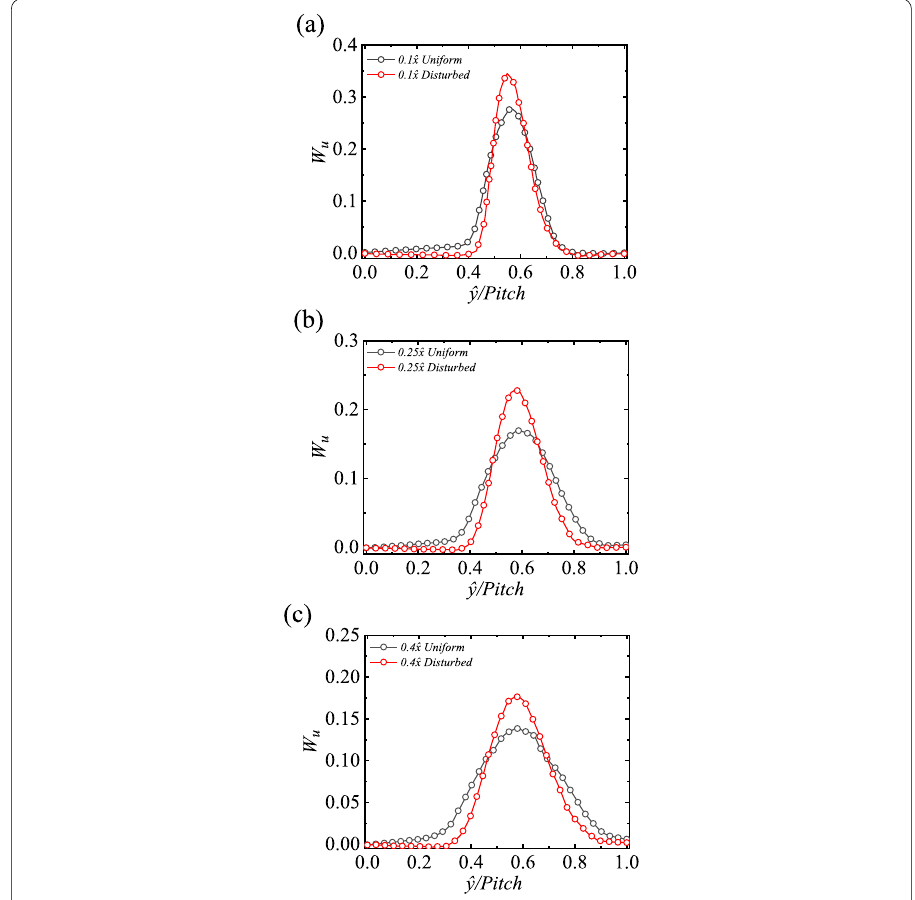
Fig. 6 Wake pressure loss coefficient at ( a ) ˆ x